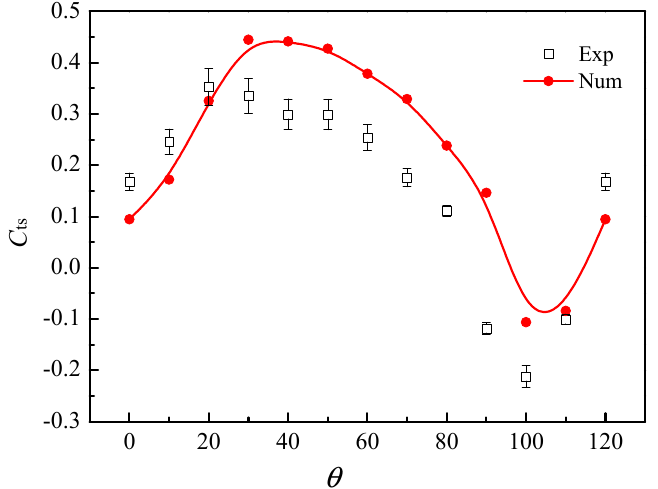
Figure 22. Curve of C ts of 3-bladed LDCS as a function of azimuth ( U = 6 m/s).